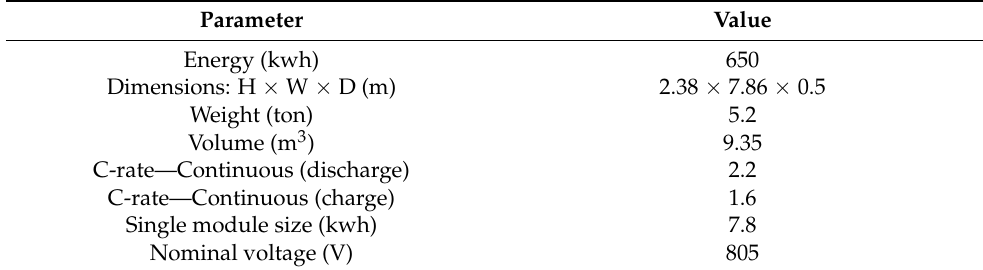
Table 6. Technical data of battery package (one set).